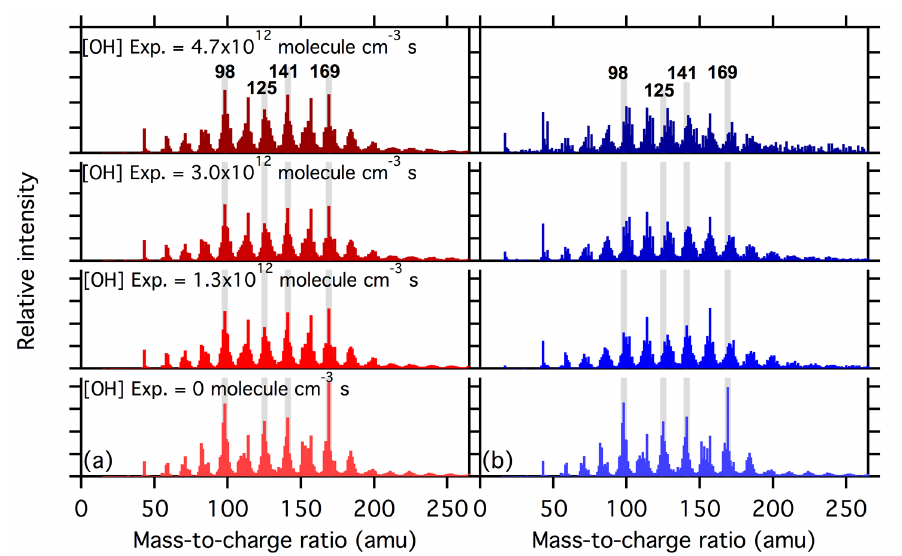
Figure 4. Example mass spectra of SOA as a function of OH exposure for (a) low-RH (red, left panels) and (b) high-RH (blue, right panels) conditions. OH exposure increases from the bottom to the top panels, with values listed in the panels. Vertical gray bars highlight four ions that exhibited a dramatic decay at high RH, but only small changes at low RH. The mass-to-charge ratio of these four ions are indicated in the figure.